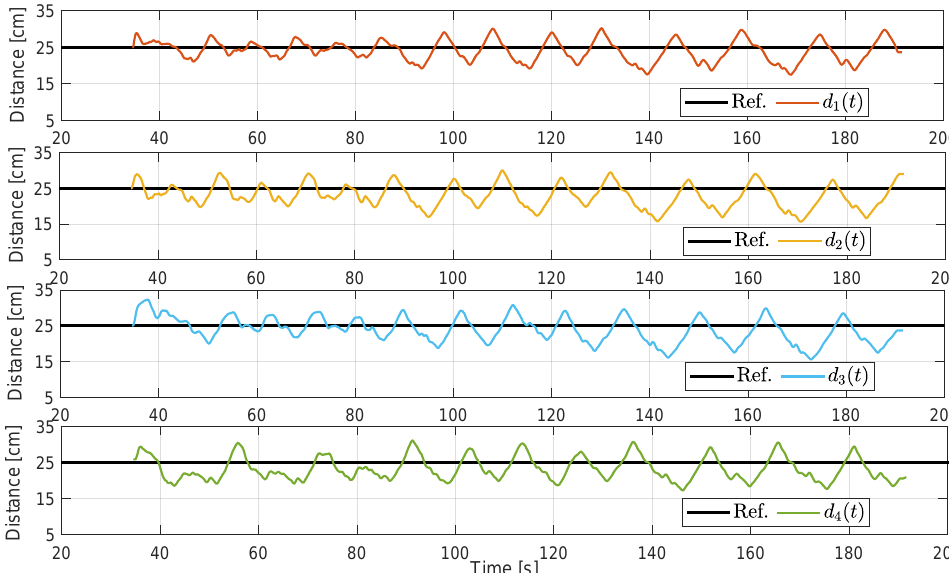
Figure 13. Distance tracking using the cooperative strategy.